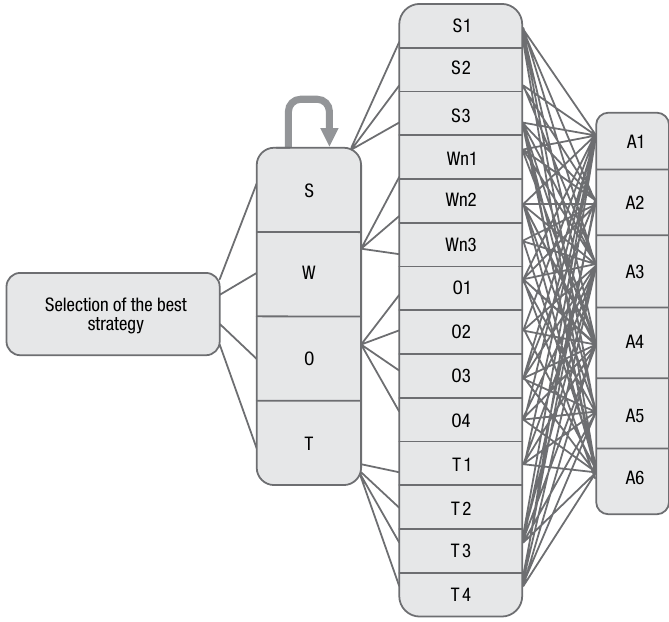
Fig. 4. The hierarchy and network